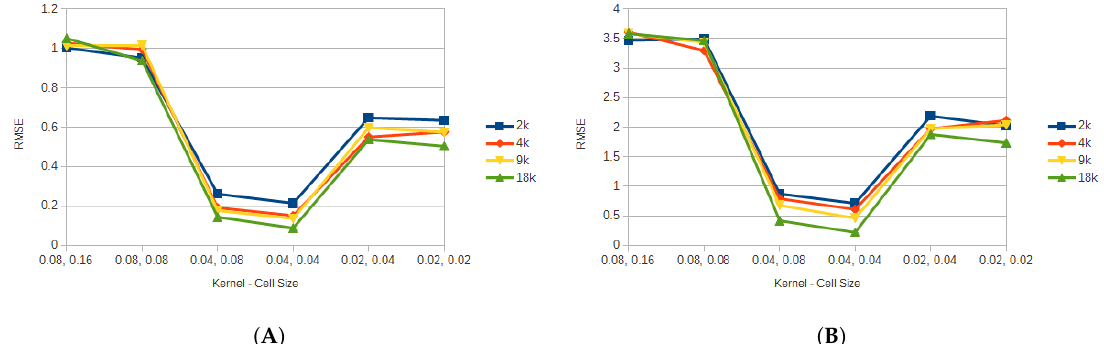
Figure 7. Average error for all the FEM resolutions for the vastus lateralis. ( A ) shows the average displacement error for all particle resolutions. ( B ) shows the average pressure error for all particle